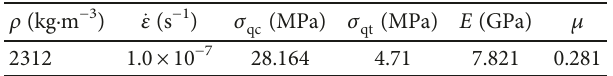
Table 1: Physicomechanical parameters of weakly weathered granites.